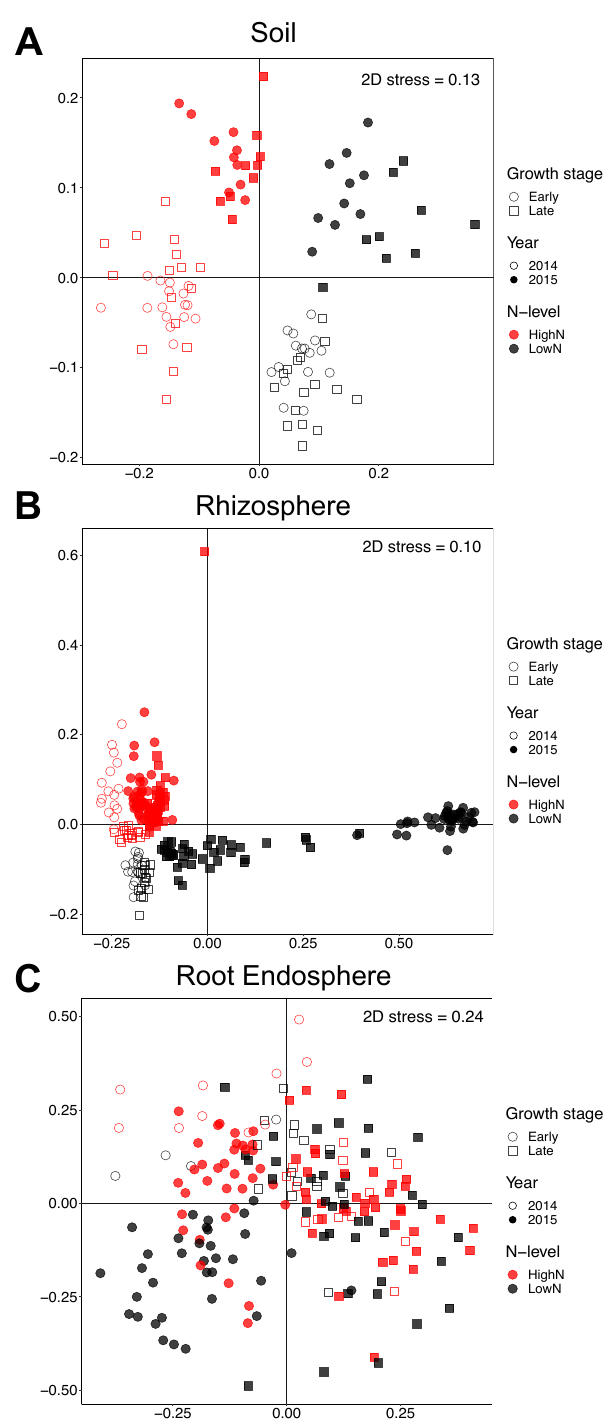
Figure 4. Changes in β -diversity showing the main factors influencing bacterial community structure in each compartment. Non-metric multidimensional scaling (NMDS) based on the Bray-Curtis distance matrices for ( A ) soil, ( B ) rhizosphere, and ( C ) root endosphere. Samples from different N- levels, plant growth stages and years of sampling are shown. Stress values are shown on each